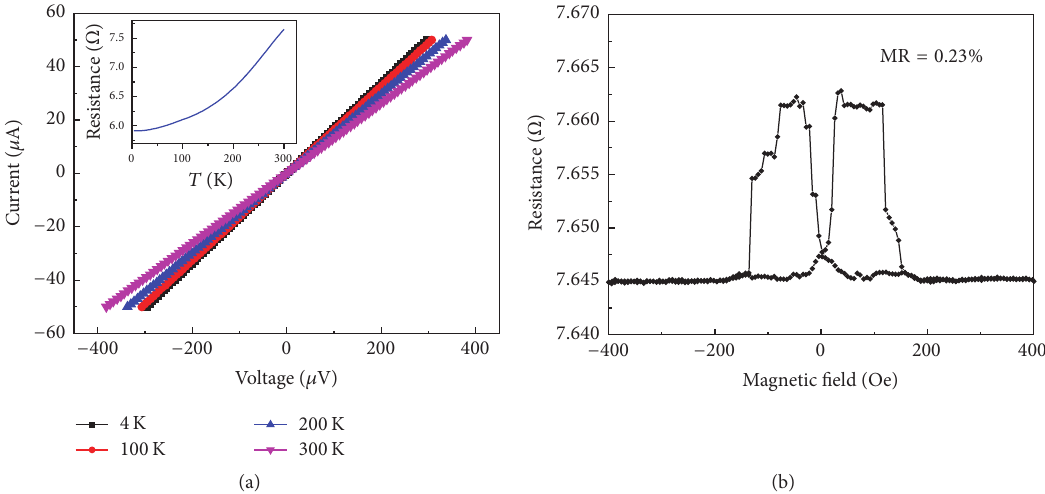
Figure 2: Characterizations of NiFe/BP/NiFe spin valve device. (a) The current-voltage curves of device at different temperature from 4 K to 300 K and resistance curve as a function of temperature at zero magnetic field in inset figure (a). (b) Resistance curves of device when external magnetic field is applied at 300 K and the value of MR is 0.23% for the structure of Py/BP/Py spin valve.